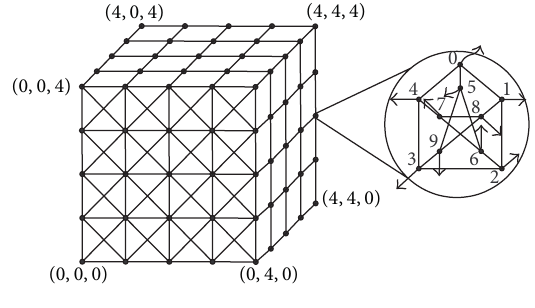
Figure 1: 3 PT (5,5, 5)